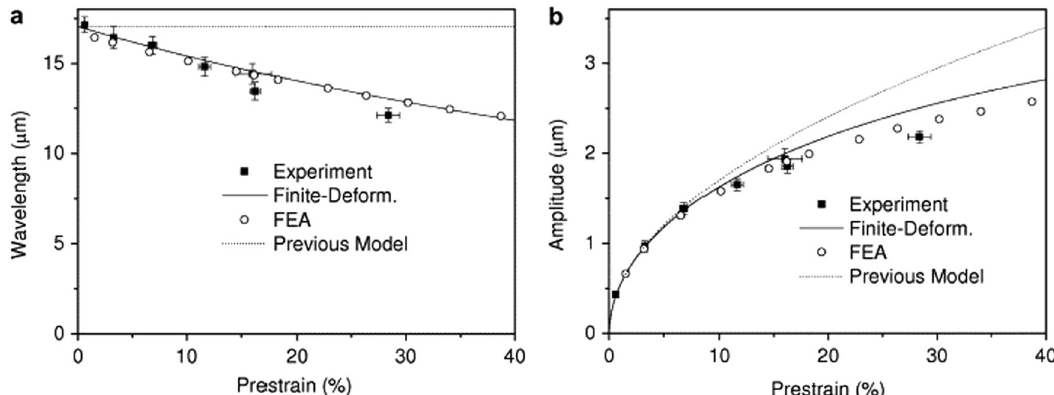
Fig. 2 a Wavelength and b amplitude of buckled structure of Si (100 nm thickness) on PDMS as a function of the pre-strain. The fi nite- deformation buckling theory yields wavelengths and amplitudes that agree well with experiments and fi nite element analysis. Results from previous mechanics models (i.e., small deformation limit) are also shown. (Reprinted with permission from ref.